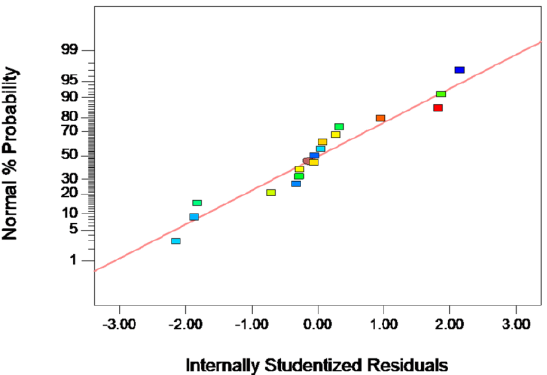
Figure 5. Normal distribution plot of residuals.